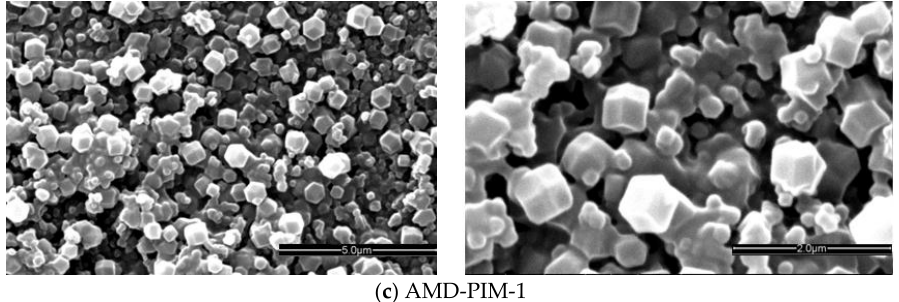
Figure 4. SEM images of ZIF-8 membranes supported on: ( a ) PIM-1 membrane; ( b ) HMDA-PIM-1 membrane and ( c ) AMD-PIM-1 membrane, all after five growth cycles.